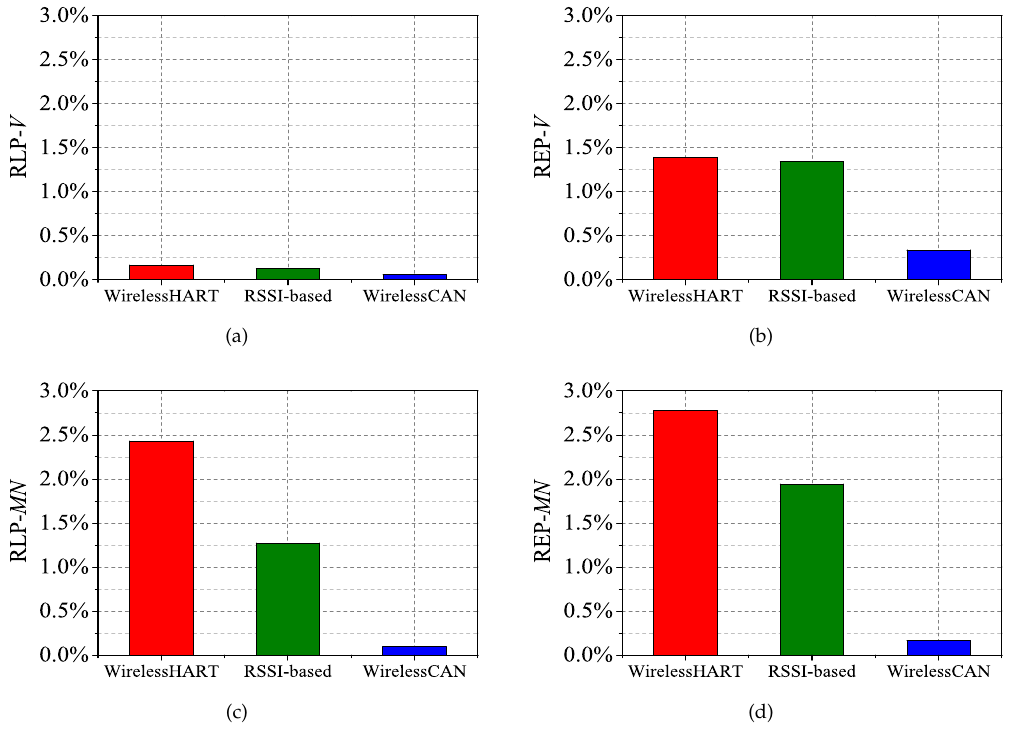
Figure 12. Comparison of RLP- V , REP- V , RLP- MN and REP- MN with a 2% packet error rate. ( a ) RLP- V ; ( b ) REP- V ; ( c ) RLP- MN ; ( d ) REP- MN